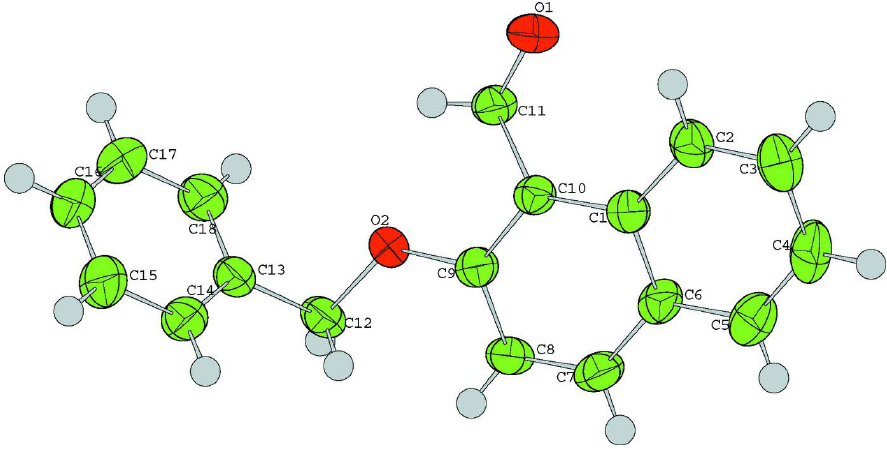
Figure 1 The molecular structure of the title compound, showing the atom-labelling scheme. Displacement ellipsoids are drawn at the 50% probability level. Hydrogen atoms are drawn as spheres of arbitrary radius.